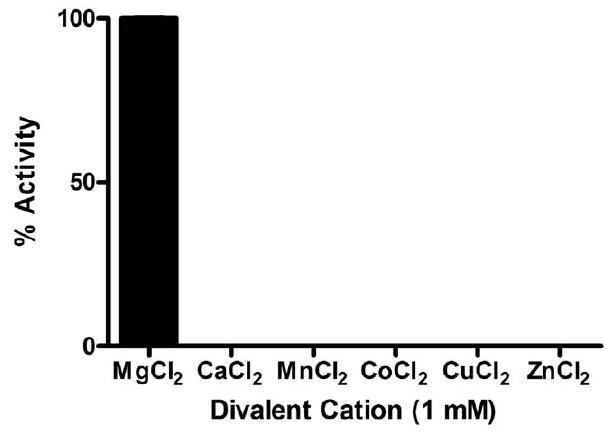
Figure 4. The divalent cation specificity of F. tularensis MEP cytidylyltransferase. Enzyme assays were performed with the indicated divalent cations at a fixed MEP (200 m M) and CTP (200 m M) concentration. Relative enzyme activity reveals the strict preference of the enzyme for Mg + 2 . Each assay was performed in duplicate.